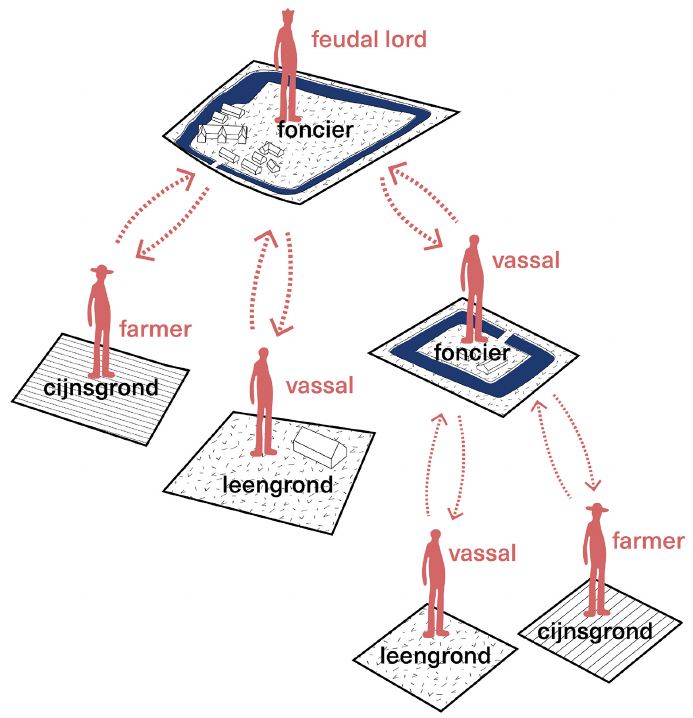
Figure 5. Moated farmsteads were ingrained in the feudal system, where a lord would allow a vassal to live and work on his land in return for revenues from labour activities. Source: Figure elaborated by Sophie Leemans, 2022. Urban Planning, 2023, Volume 8, Issue 1, Pages